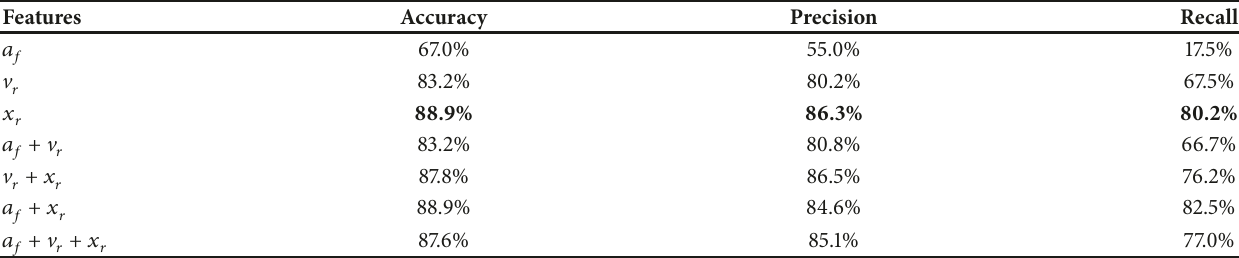
Table 3: The evaluation results of driving style based on SVM using DFT.